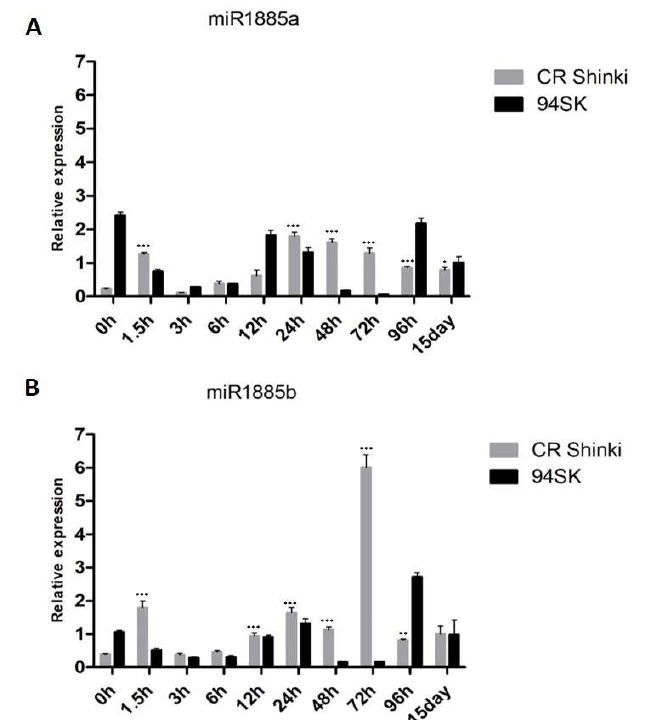
Figure 2. Expression of ( A ) miR1885a and ( B ) miR1885b in the roots of inbred lines CR Shinki (re- sistant) and 94SK (susceptible) inoculated with P. brassicae . The expression of both miRNAs in- creased significantly in CR Shinki